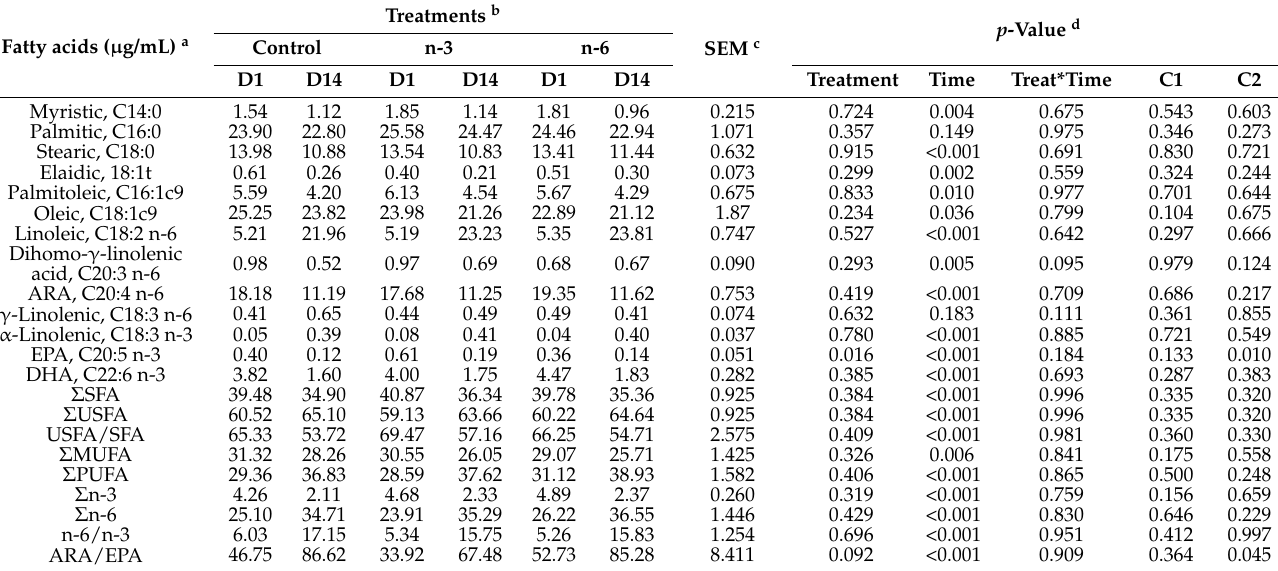
Table 12. Piglet serum fatty acids profile at 1 and 14 days